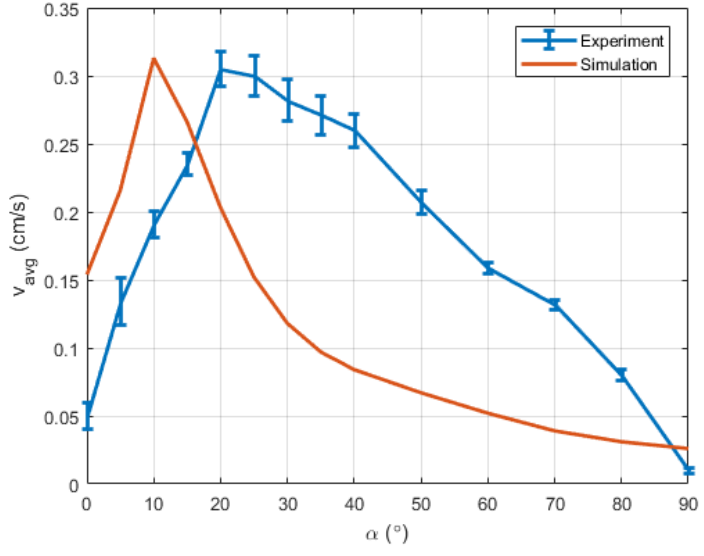
Figure 11. Average speed of the swimmer versus fin angle from experiments and simulations. Although the trends are the same in both cases, including the predicted maximum average swimming speed, which differs by only about 7% between the experiments and theory, the experiments reveal a higher optimal fin angle than that predicted by the two-dimensional theoretical